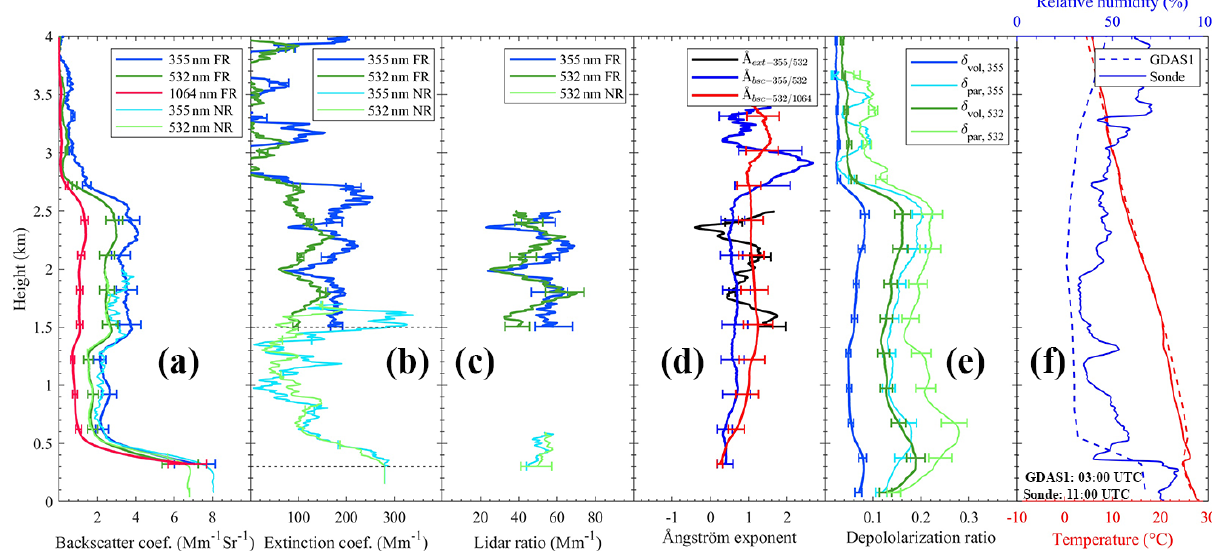
Figure 8. Raman lidar observation on 26 November 2018 at 02:00–03:00UTC. (a) Particle backscatter coefficients, (b) particle extinction coefficients (Raman lidar method), (c) lidar ratio, (d) Ångström exponents computed from different wavelength pairs in panels (a) and (b) , (e) volume ( δ vol ) and particle ( δ par ) depolarization ratios and (f) relative humidity (blue) and temperature (red) from radiosonde observations and GDAS1 data.